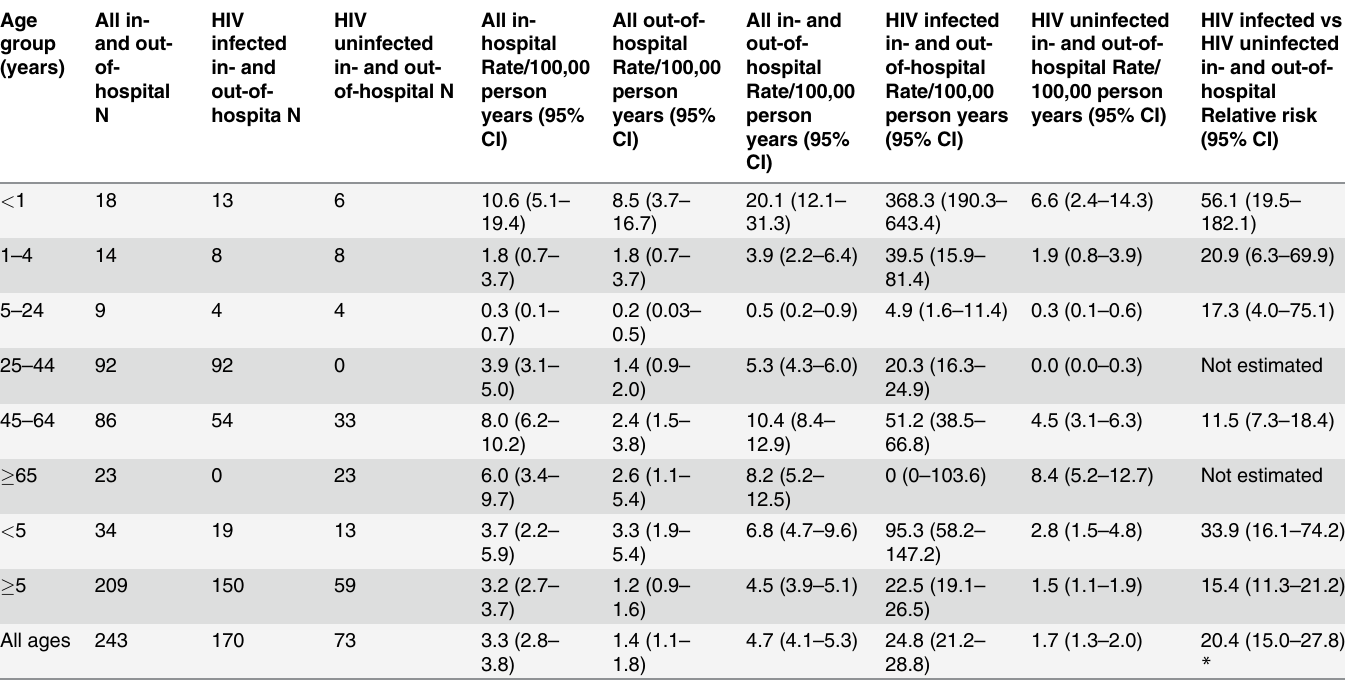
Table 2. Incidence of mortality for in fl uenza-associated severe acute respiratory illness per 100,000 person years by HIV status in Soweto, South Africa, 2009 –